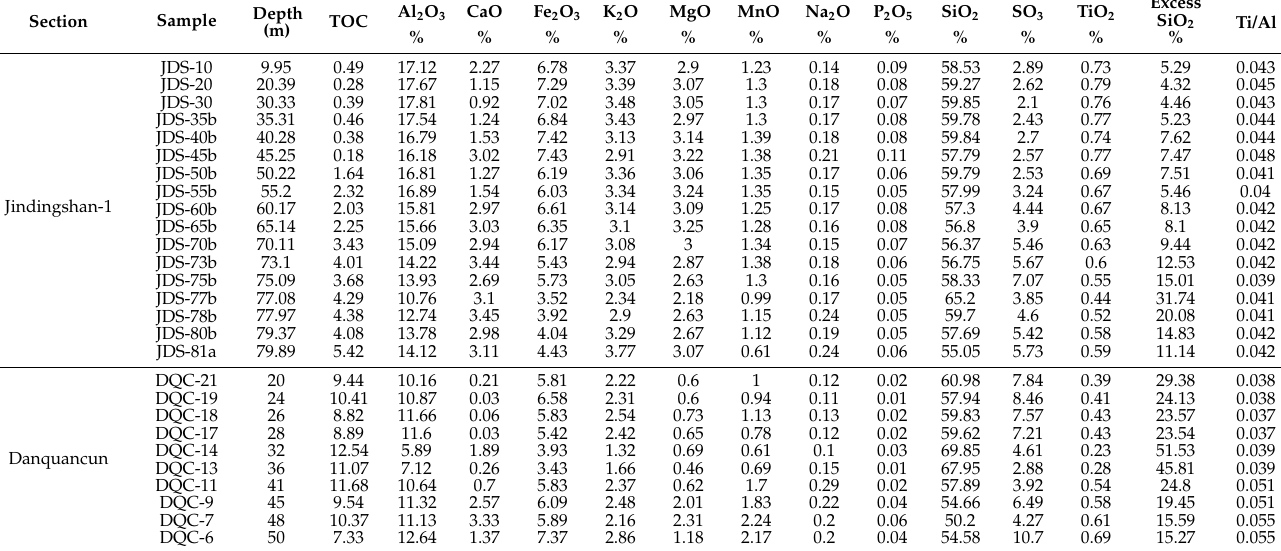
Table 3. Major oxides of the Niutitang shale in the Jindingshan-1 (JDS-1) well and Danquancun (DQC)